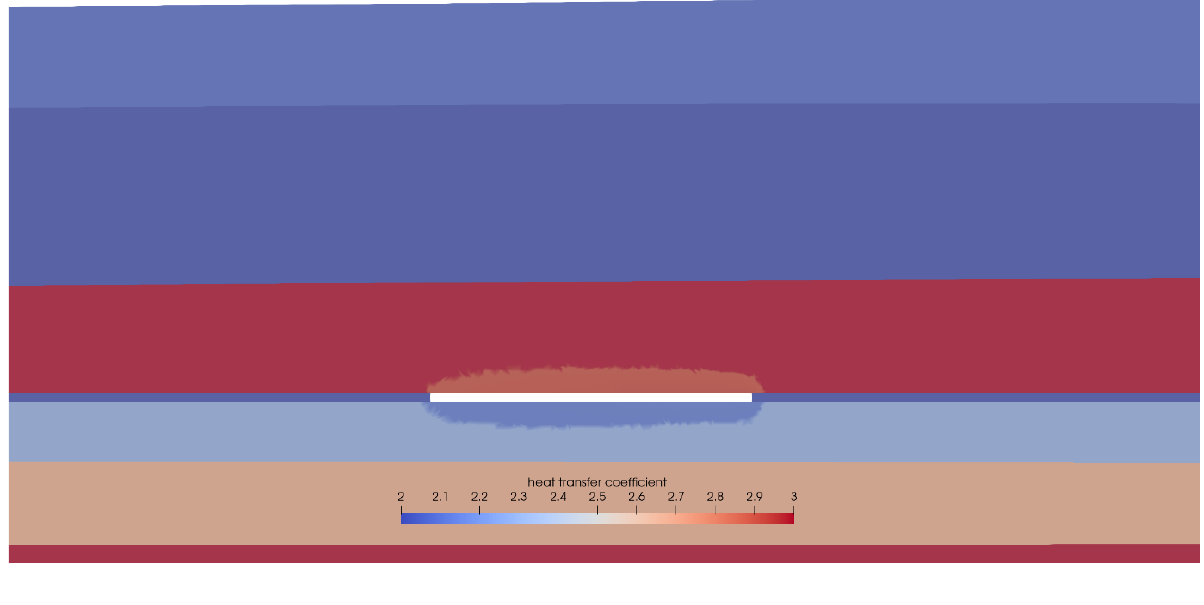
Water seepage rate vectors at t = 1.5 year are shown in fig. 13 – their direction indicates that water reaches